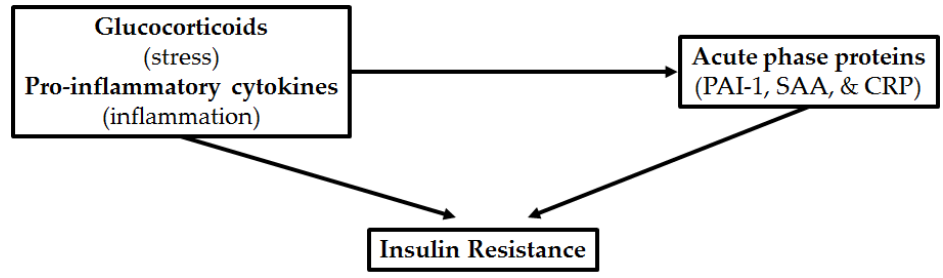
Figure 1. Acute phase protein, plasminogen activator inhibitor-1 (PAI-1), serum amyloid A (SAA), and C-reactive protein (CRP), expression is regulated by glucocorticoids and pro-inflammatory cytokines. APPs may be the causative link between stress and inflammation and the development of insulin resistance.